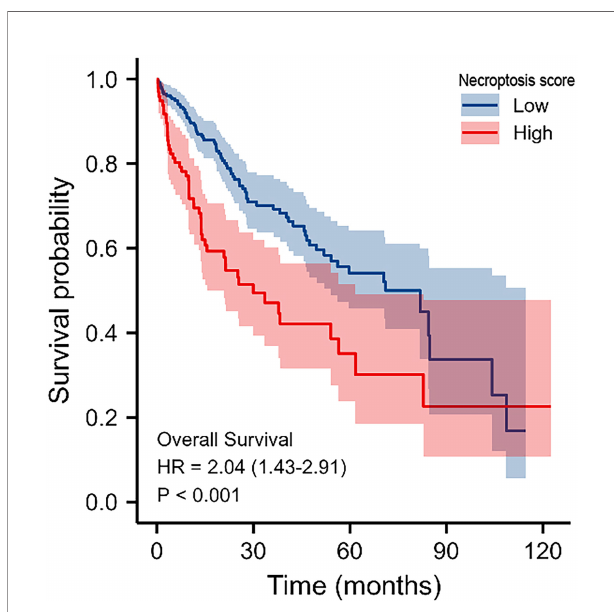
FIGURE 11 | KM survival analysis of high ‐ and low ‐ necroptosis score HCC